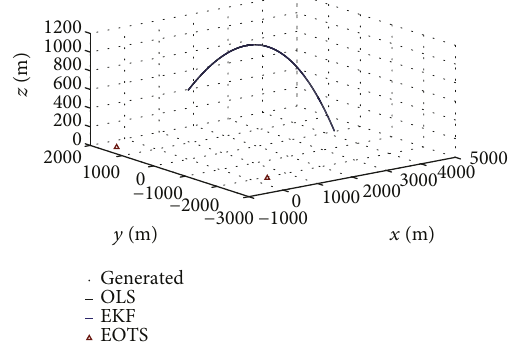
Figure 8: Simulated and estimated velocity of ICP-89.